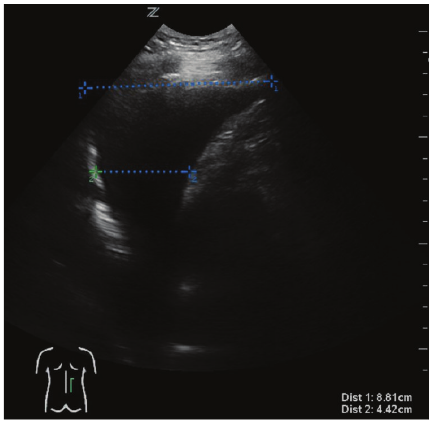
Figure 4: Ultrasound of lower thorax.